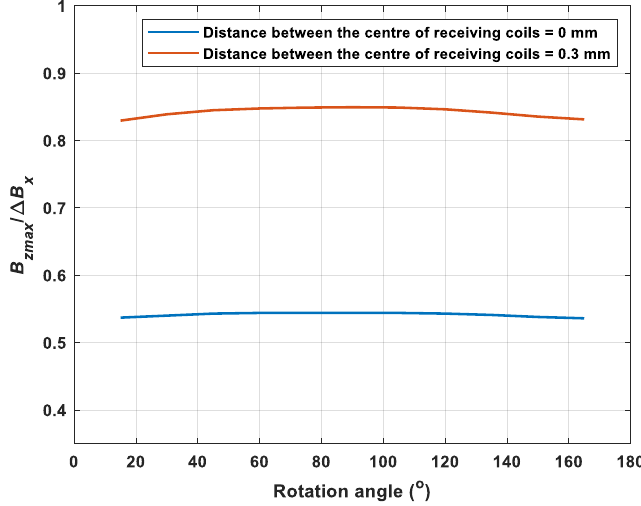
Figure 6. The ratio of the maximum of the z component and the change of the x component under varying rotation angles for different distance between the centre of receiving coils with the crack depth of 2 mm.